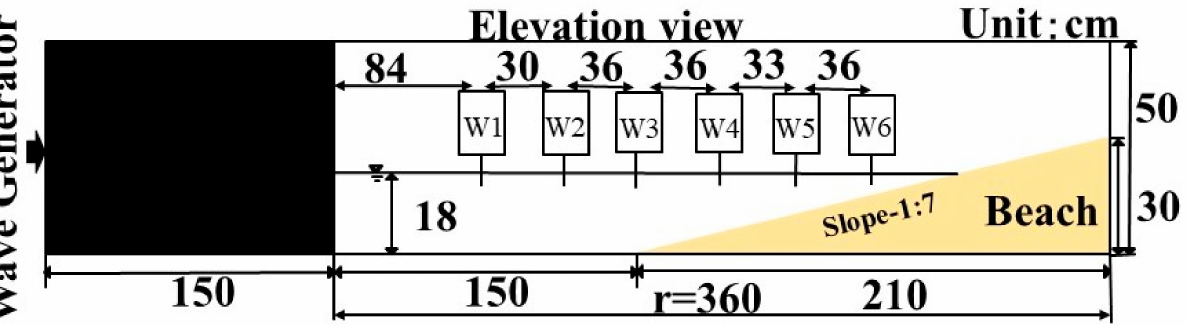
Figure 2. Initial sectional view of the terrain. W: wave gauge.